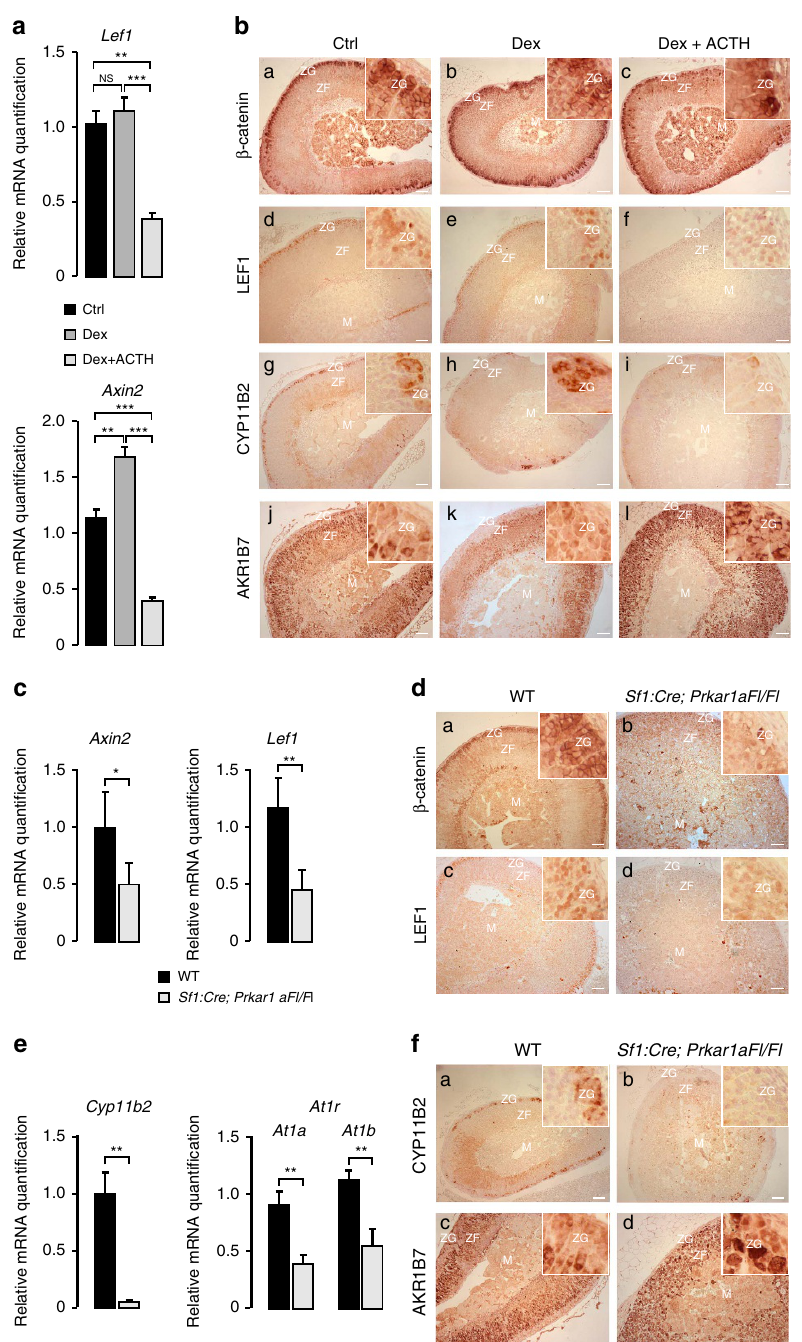
Figure 1 | Antagonistic effects of PKA on WNT signalling and ZG differentiation. ( a ) ACTH treatment inhibits WNT target genes expression in the adrenal gland. Wild-type C57/Bl6 mice were treated for 5 days with vehicle (Ctrl) or Dexamethasone (Dex) or for 3 days with dexamethasone followed by 2 days of Synacthene retard (Dex þ ACTH). Lef1 and Axin2 expression levels were then analysed by RT–qPCR on mRNAs extracted from the adrenals. Bars represent mean expression in four animals per group ± s.e.m. ( b ) WNT pathway and ZG differentiation are inhibited by ACTH treatment. Expression of b -catenin, LEF1 (WNTpathway), AKR1B7 (ZF) and CYP11B2 (ZG) was analysed by immunohistochemistry in the adrenals from the same animal groups as in a . ( c ) Constitutive activation of PKA signalling inhibits WNT target genes expression in the adrenal gland. Axin2 and Lef1 expression levels were analysed by RT–qPCR on mRNAs extracted from wild-type and Sf1:Cre;Prkar1aFl/Fl adrenals. ( d ) Constitutive activation of PKA signalling inhibits b -catenin and LEF1 accumulation in ZG. Expression of b -catenin and LEF1 was analysed by immunohistochemistry in the adrenals from wild-type and Sf1:Cre;Prkar1aFl/Fl adrenals. ( e ) ZG differentiation is inhibited by constitutive PKA signalling. Cyp11b2 and angiotensin II receptor AT1R isoforms a and b expression levels were analysed by RT–qPCR on mRNAs extracted from wild-type and Sf1:Cre;Prkar1aFl/Fl adrenals. ( f ) Constitutive PKA signalling promotes ZF differentiation at the expense of ZG. Expression of CYP11B2 and AKR1B7 was analysed by immunohistochemistry in the adrenals from wild-type and Sf1:Cre;Prkar1aFl/Fl adrenals. In c , e , bars represent mean expression in six animals per group ± s.e.m. Statistical analyses were conducted by one-way ANOVA followed by Tukey’s post hoc test ( a ) or by Student’s t -test ( c , e ). * P o 0.05; ** P o 0.005; *** P o 0.0005; NS, not significant. In all the images, insets are focused on ZG. Scale bars, 100 m m. M, medulla; ZG, zona glomerulosa; ZF, zona fasciculata. NATURE COMMUNICATIONS|7:12751|DOI: